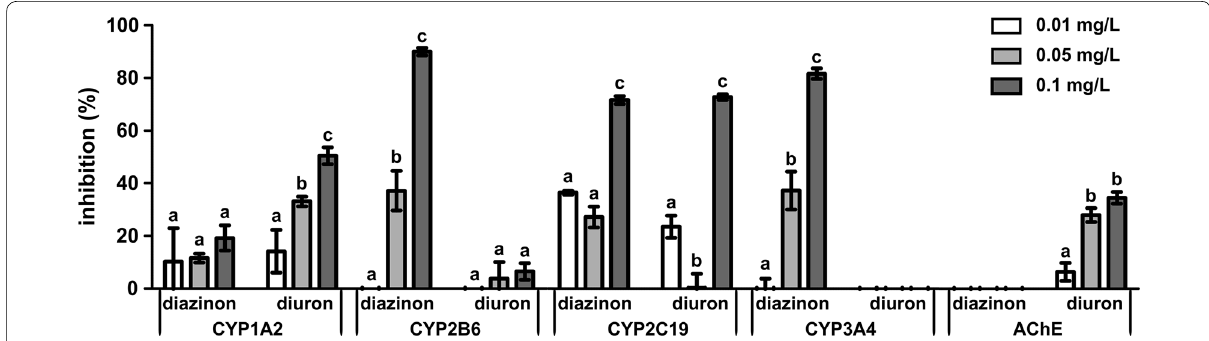
Fig. 6 In vitro inhibition of different enzymes after exposure to diazinon and diuron. Bars represent means with standard deviation of three replicates. Significant differences between different concentrations are labeled with different letters ( p < 0.05)